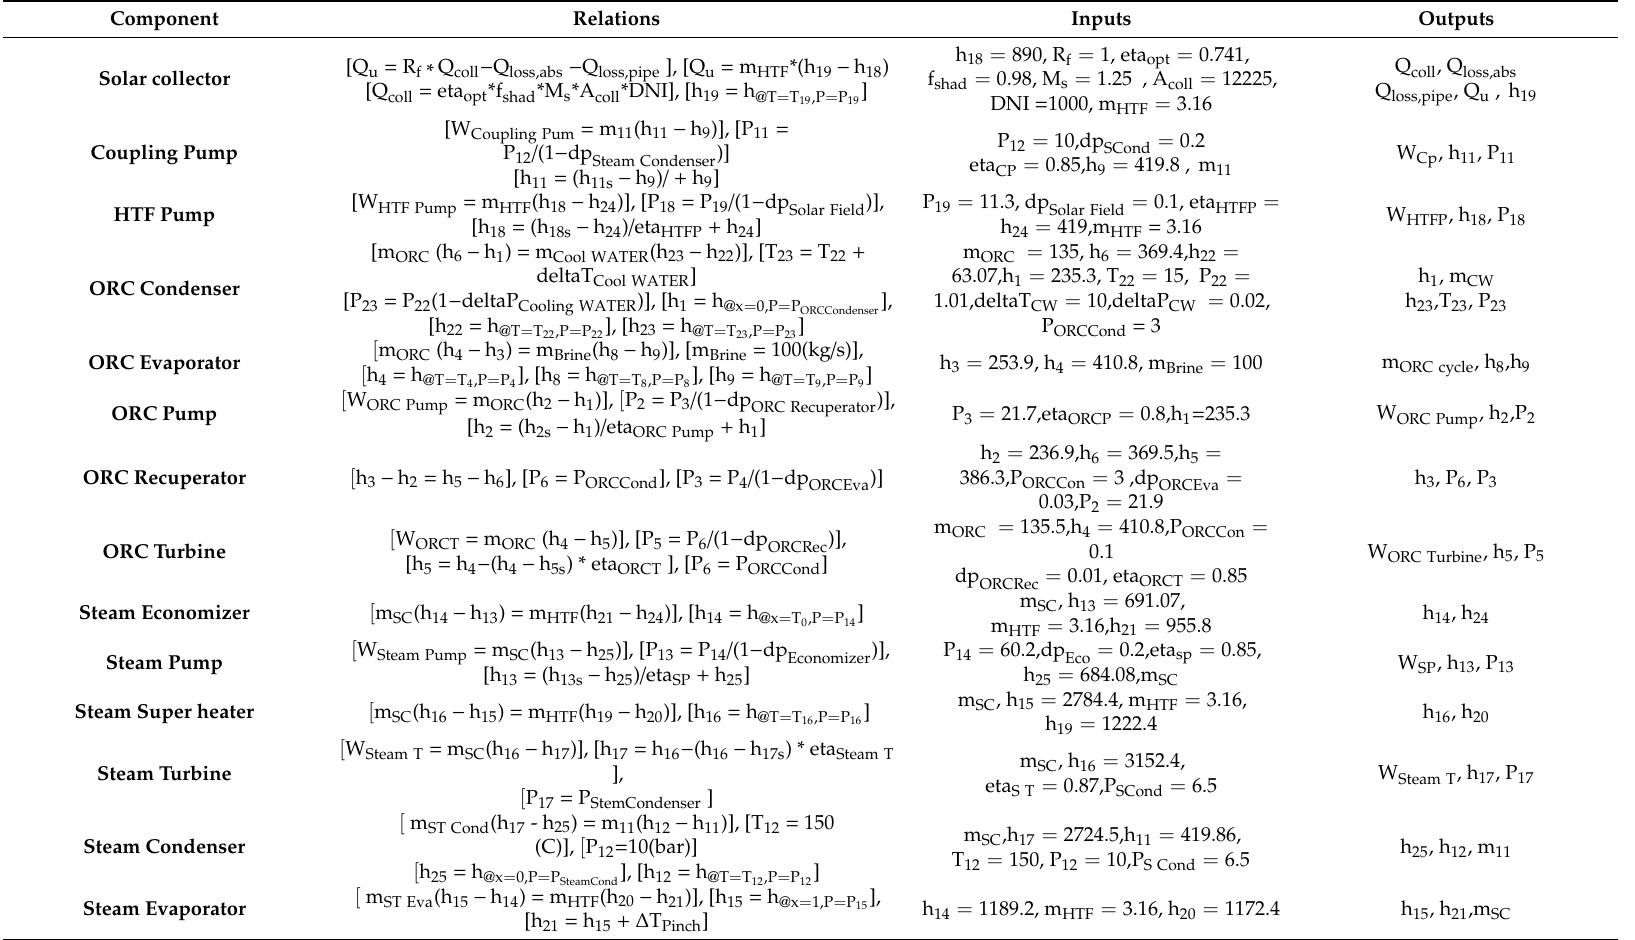
Table A3. Equations and theoretical analysis for Component of